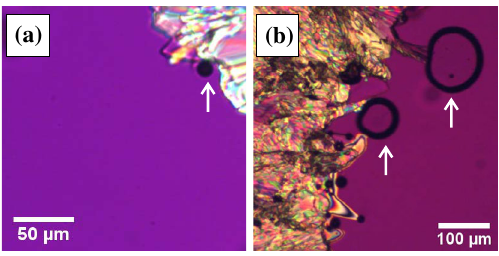
Figure 1. Microscopy observation of crystal growth in ( a ) OTP at 283 K and ( b ) salol at 278 K. The arrows in ( a , b ) indicate the emerged bubble during the crystal